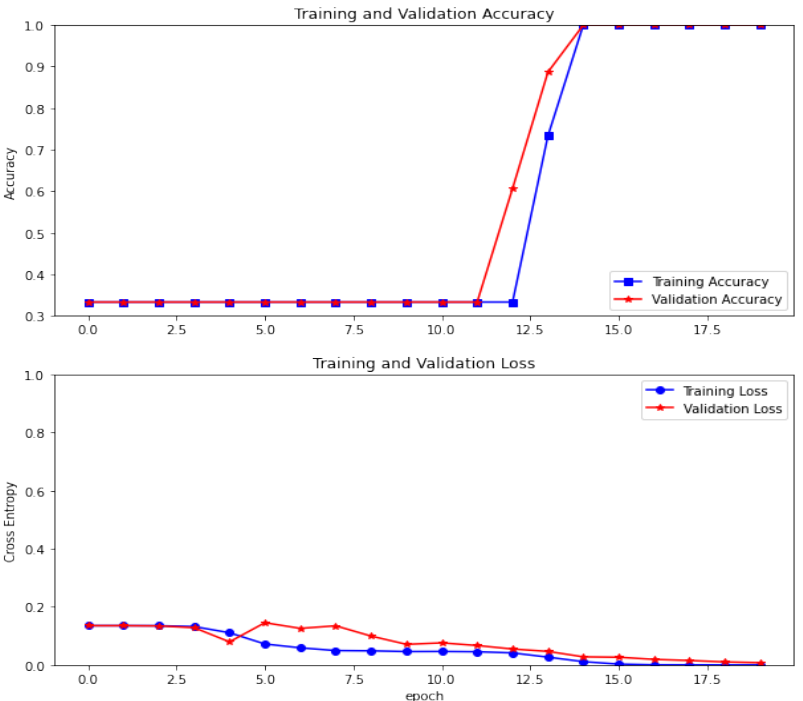
Figure 9. The accuracy and loss of training dataset and validation dataset. Table 3. The validation accuracy using different training datasets.